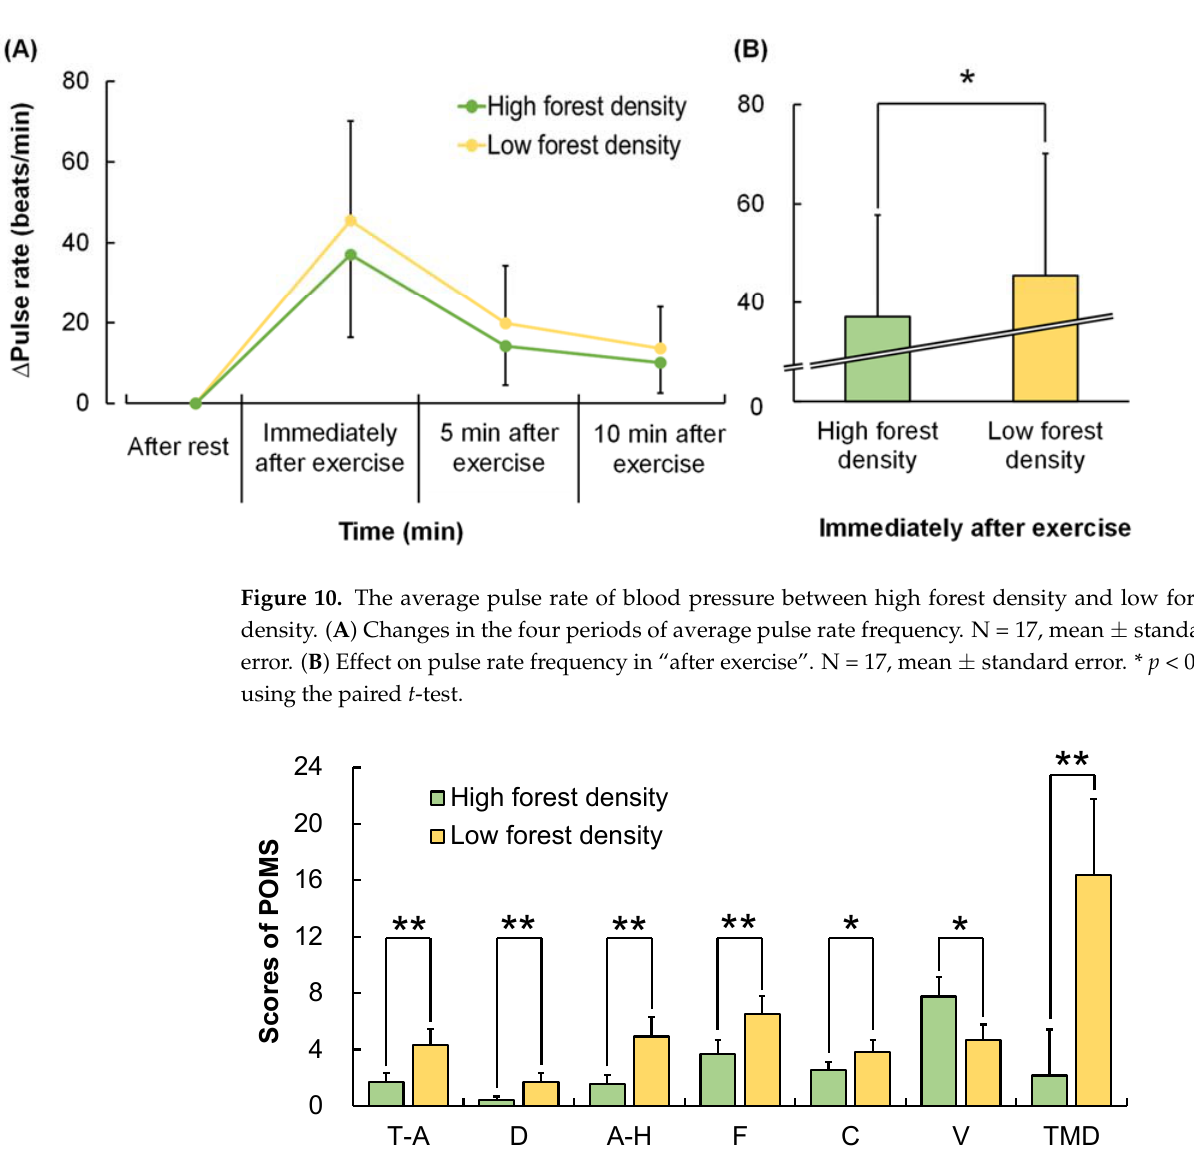
Figure 11. Comparison of profile of mood state (POMS) scores in the “after exercise” between high forest density and low forest density. T ‐ A, tension ‐ anxiety; D, depression; A ‐ H, anger ‐ hostility; F, fatigue; C, confusion; V, vigor; TMD, total mood disturbance. N = 17–18, mean ± standard error. * p < 0.05, ** p < 0.01 using the Wilcoxon signed ‐ rank test.